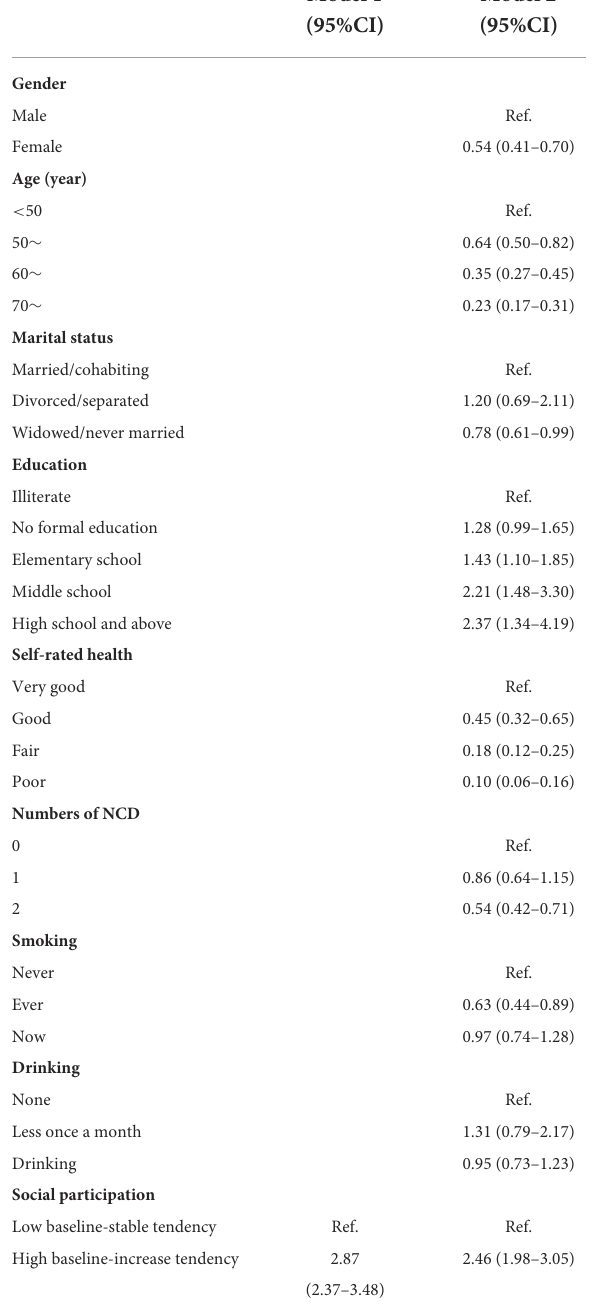
TABLE 3 Multinomial logistic regression of association between trajectories of social participation and functional